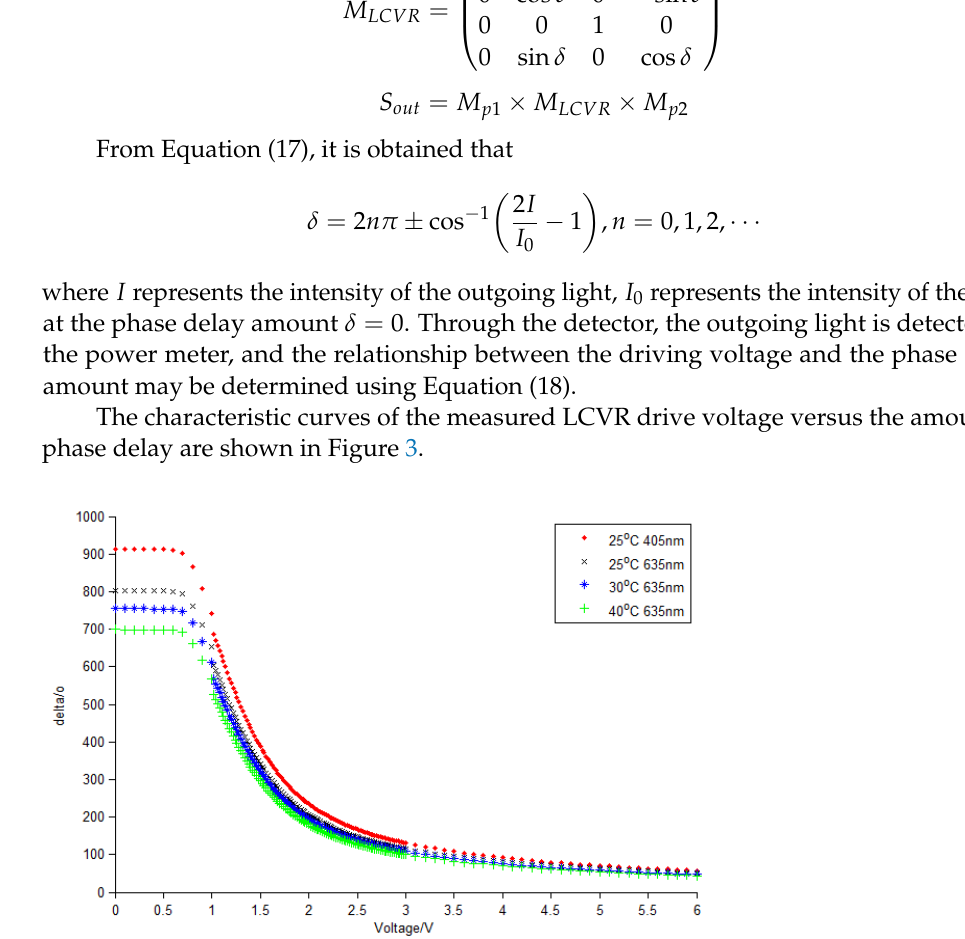
Figure 3. LCVR phase delay characteristic curve.